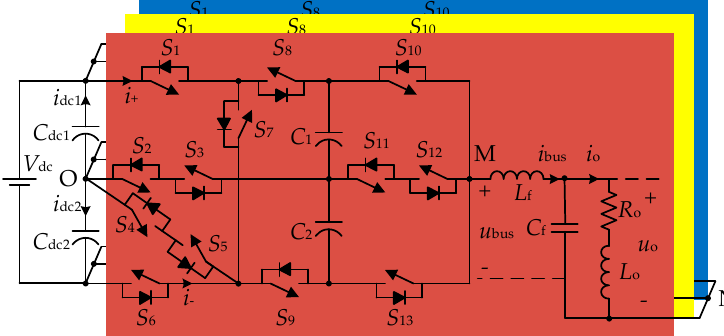
Figure 1. Proposed seven-level three-phase SCMLI topology.